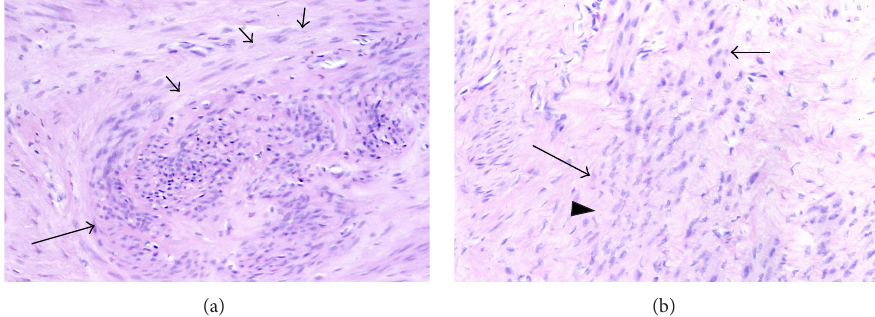
Figure 3: Phenotypic transformation from smooth muscle cells to fibroblast-like cells. In (a), the cells in the center and to the right are in close fascicular apposition and exhibit the typical pink cytoplasm of smooth muscle cells, while the cells above and to the left are more widely separated and have a paler cytoplasm resembling that of fibroblasts. Note that as the smooth muscle cells at the bottom (long arrow) appear to stream upwards and then to the right, there is a morphologic transformation to fibroblast-like cells with paler cytoplasm (short arrows). A similar transformation is noted in (b) as the organized, closely packed smooth muscle cells with pinker cytoplasm at the top (short arrow) transform into more widely spaced, paler fibroblast-like cells in the bottom half (long arrow). Note that the transformed cells have already produced a collagenous stroma (arrowhead), and that the cytoplasm of the transformed cells is less distinct and not clearly contiguous with that of their neighbors. Original magnification of (a) and (b): 66x.